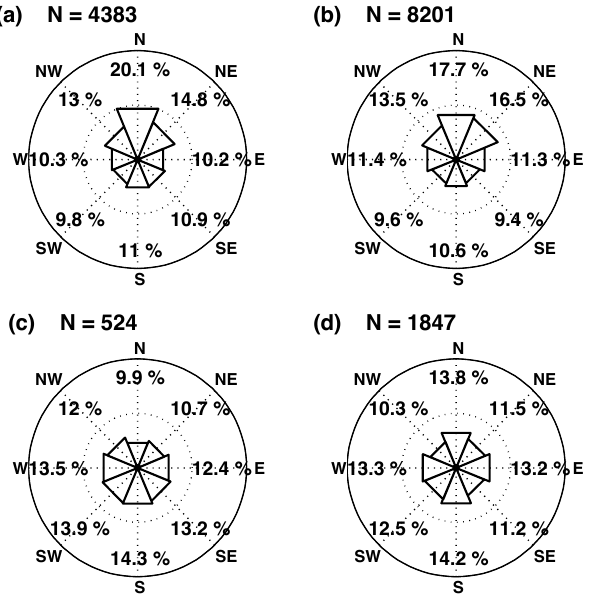
Figure 6. Horizontal propagation directions of IGWs for summer and winter season of upward energy propagating waves (a) and (b) respectively and downward energy propagating waves (c) and (d) respectively.